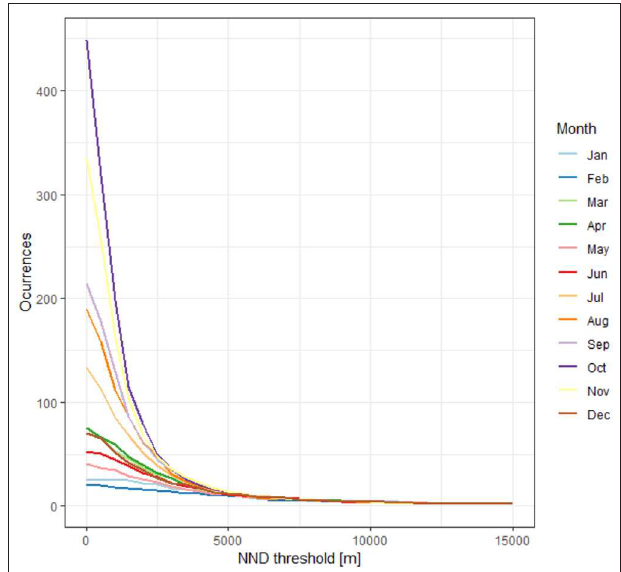
FIGURE 1 | Occurrence records of monarch butterflies remaining after a geographical thinning at different nearest neighbor